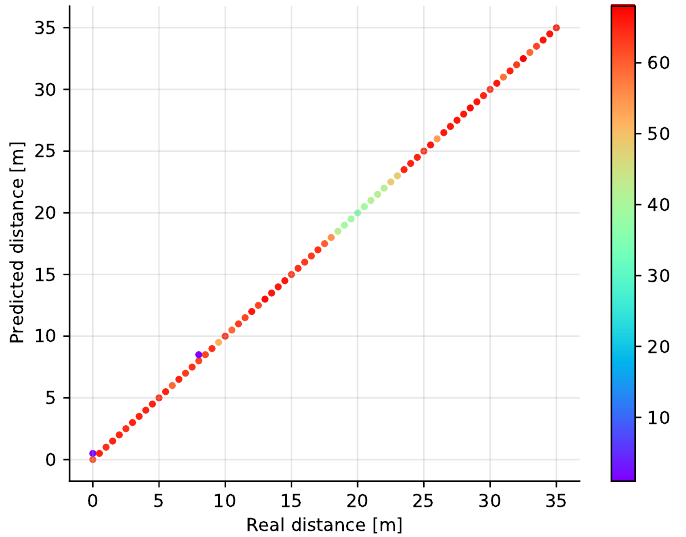
Figure 12. Scatter plot showing the predicted versus the real distances in a single dimension with the Random Forest classifier with the number of trees equal to